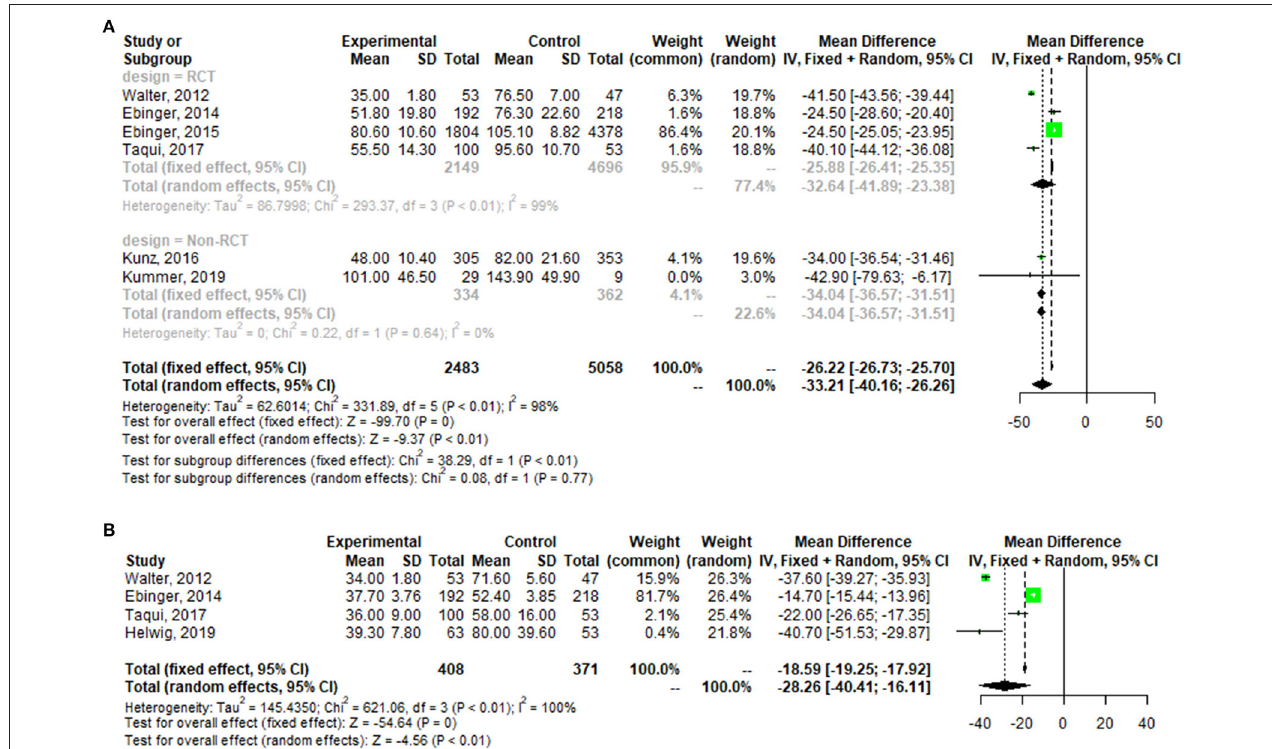
FIGURE 3 | Forest plot for change in the time from alarm to therapy decision (A) , and the time from alarm to CT completion (B) .